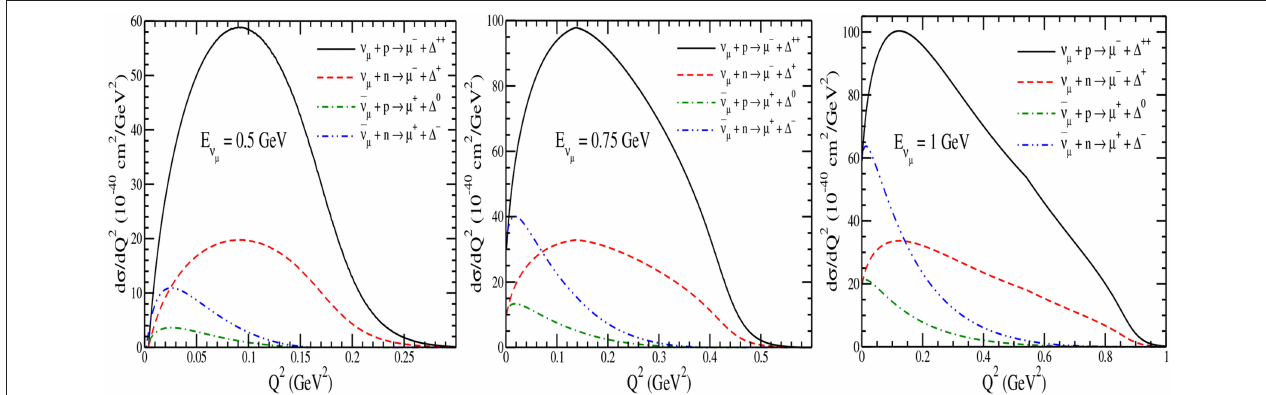
FIGURE 11 | σ vs. E ν µ for the 1 0 production cross sections without (solid line) and with (dashed line) NME for the various nuclear targets. Ratio, σ Y /σ 1 0 vs. E ¯ without (dash-dotted line) and with (dash-double-dotted) NME for the various nuclear targets are presented in the inset.